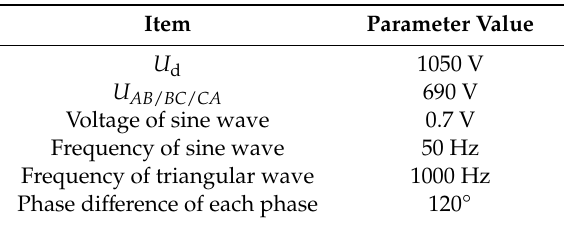
Table 2. Parameters of simulation